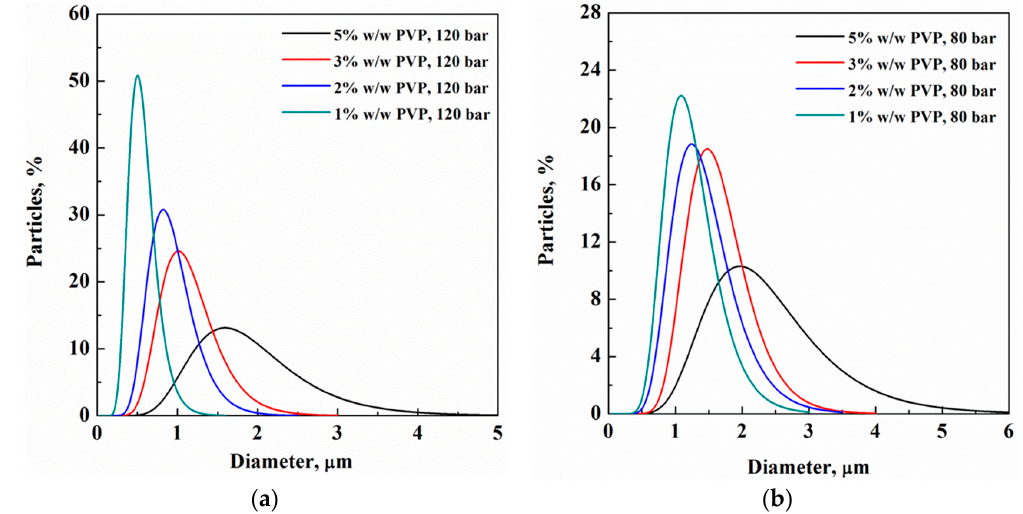
Figure 5. PSD of PVP particles obtained at 1, 2, 3 and 5% w/w , working at ( a ) 120 bar and ( b ) 80 bar.